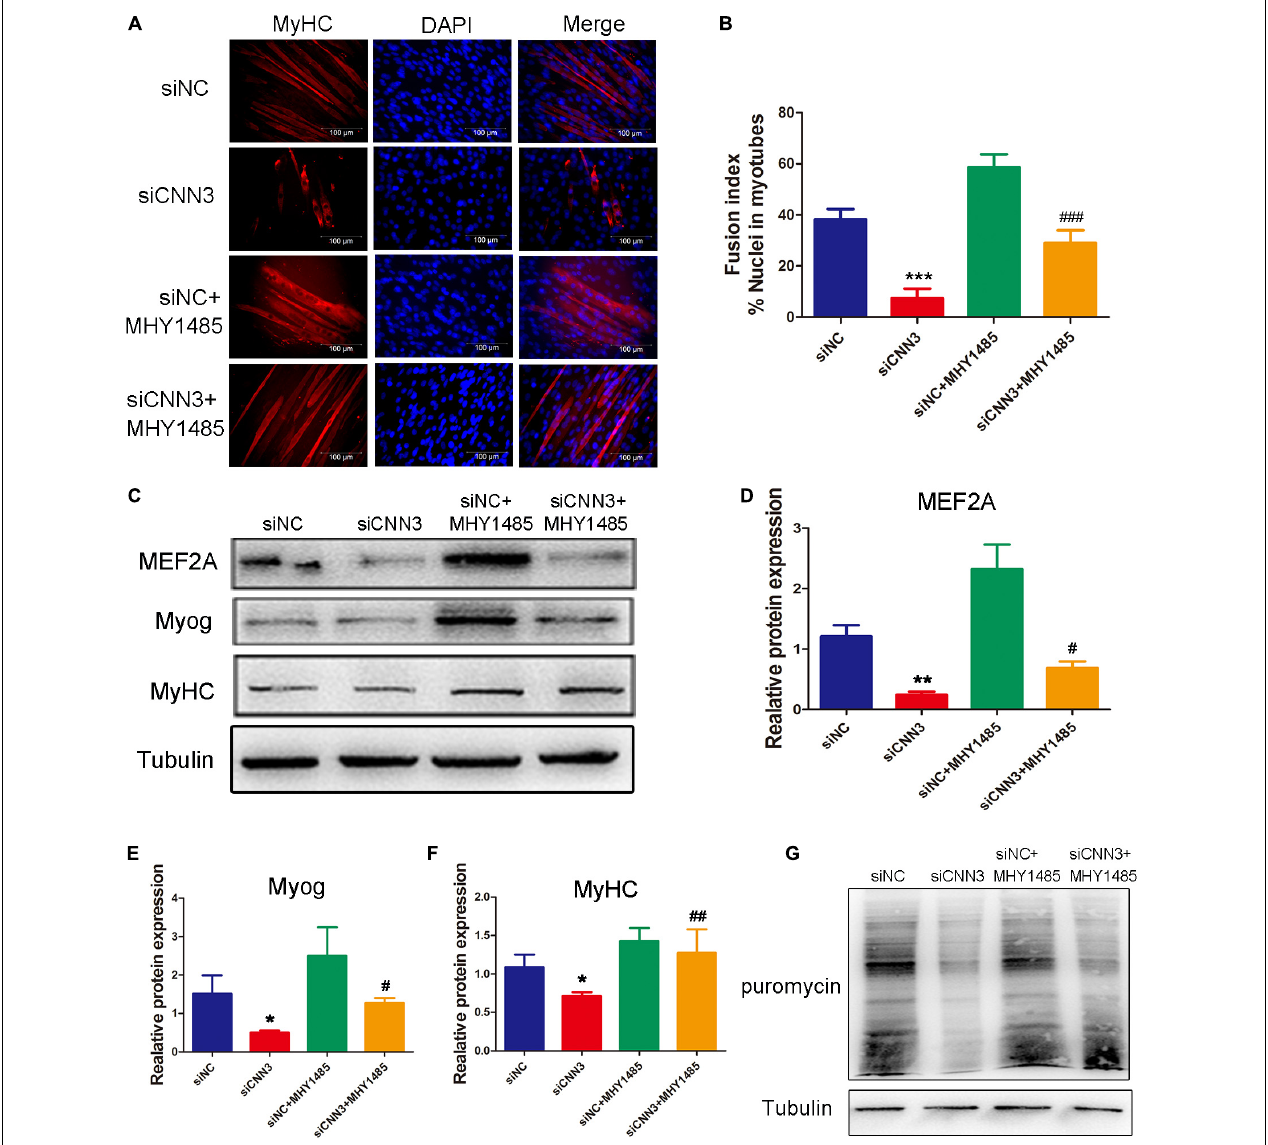
FIGURE 6 | MHY1485 treatment restored myogenic differentiation and protein synthesis in CNN3 knockdown cells. (A) Representative images of differentiating C2C12 cells stained with an anti-MyHC antibody. The red color indicates MyHC staining, and the blue color indicates DAPI nuclear staining. Scale bars = 100 µ m. (B) The fusion indices quantified for each group. (C) Western blot analysis of CDK2, CDK4, and CDK6. (D–F) Quantification of the Western blot bands by Image J, using tubulin as the internal control. (G) Newly synthesized proteins detected by Western blot analysis using an anti-puromycin antibody. * P < 0.05, ** P < 0.01, *** P < 0.001 compared with the NC siRNA (siNC) group; # P < 0.05, ## P < 0.01, ### P < 0.001 compared with the CNN3 knockdown (siCNN3)